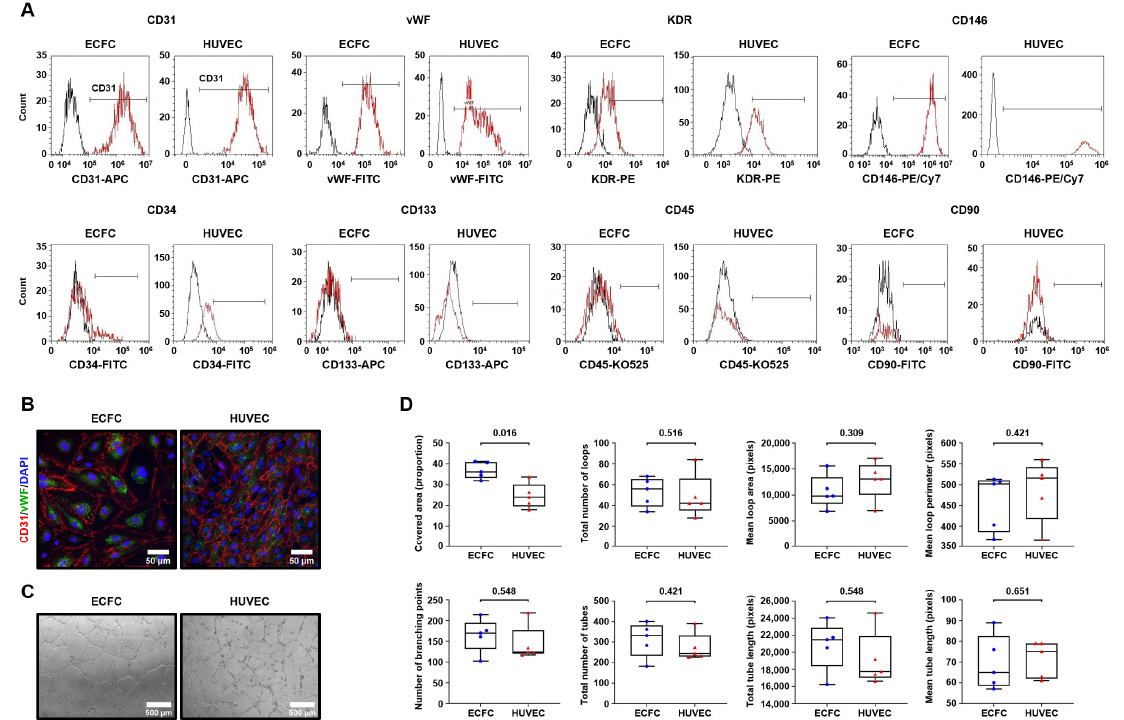
Figure 1. Peripheral blood mononuclear cells (PBMC)-derived endothelial colony-forming cells (ECFC) have characteristic endothelial immunophenotype and considerable tube-forming activity in